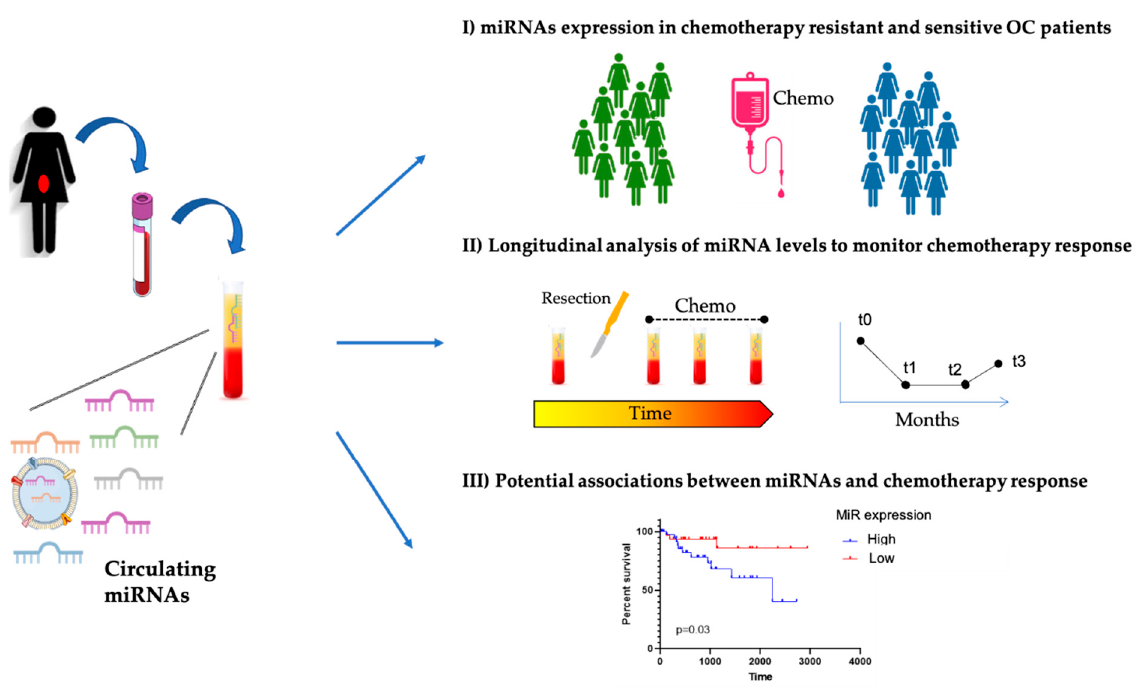
Figure 2. Main types of studies investigating circulating miRNAs and therapeutic response in EOC.